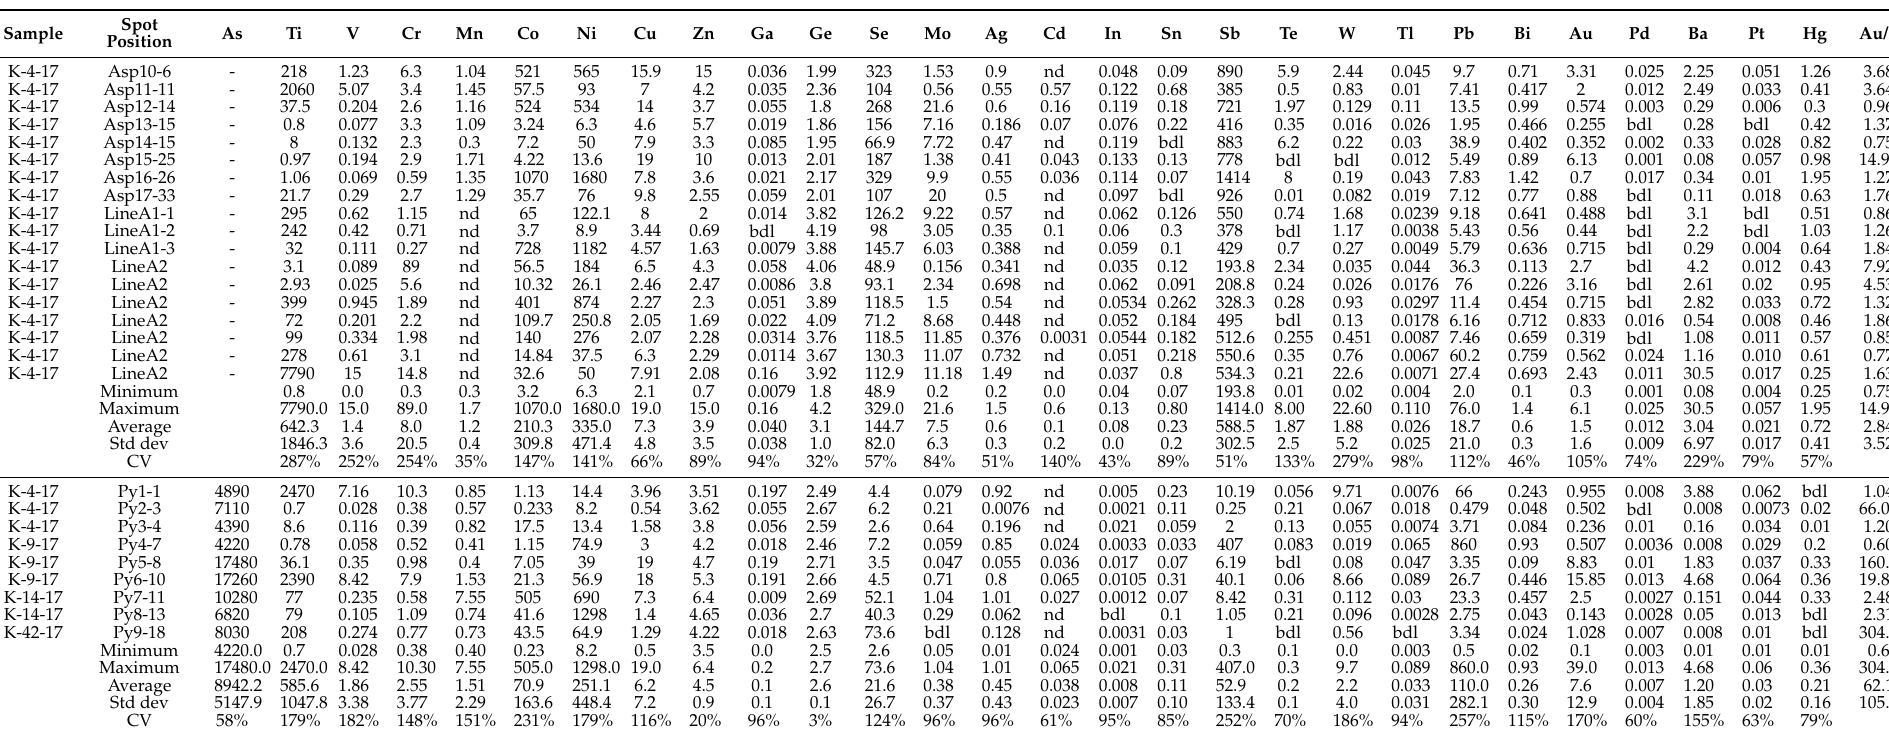
Table 2. Data of LA-ICP-MS trace element analysis of Py3 and Apy1 of Khangalas gold deposit (all values in ppm; bdl, below detection limit; nd, not